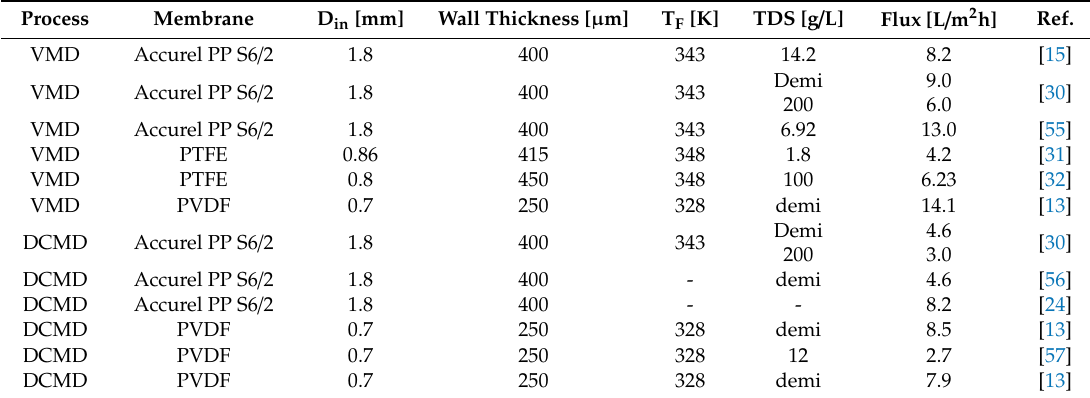
Table 4. Comparison of the results of the MD process obtained for different submerged MD modules.